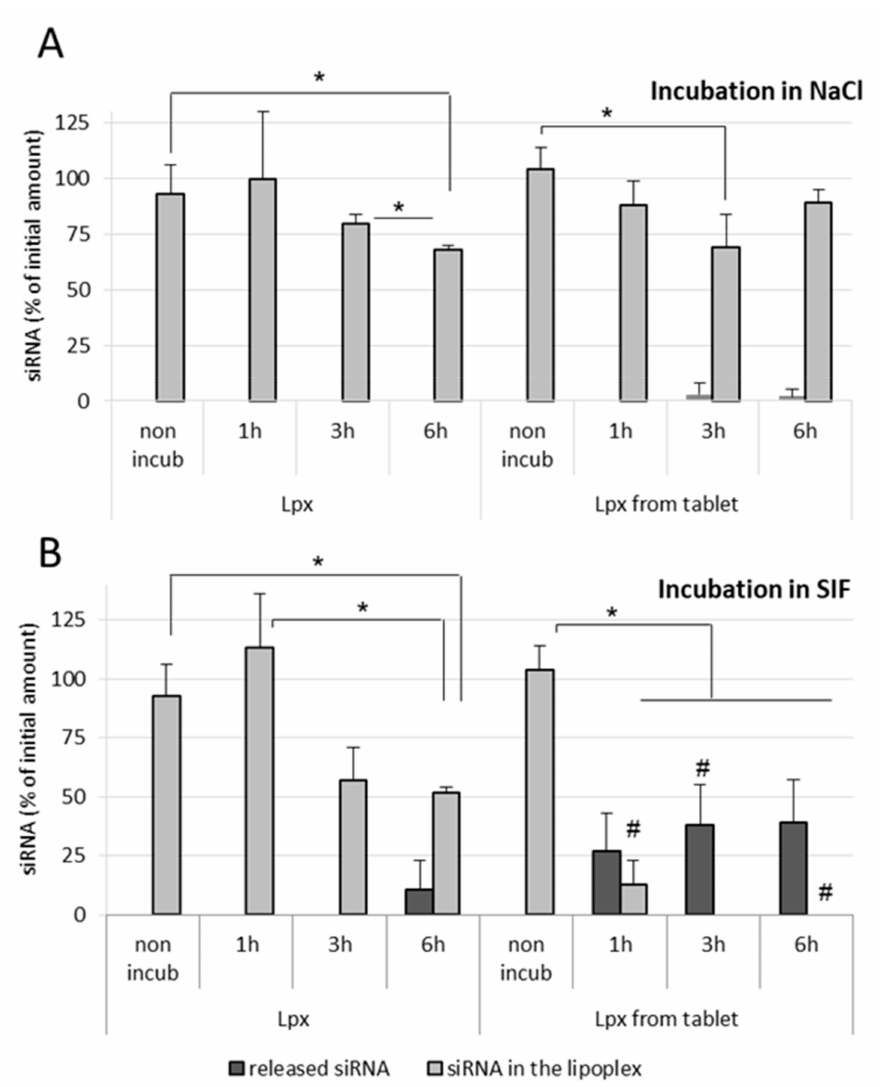
Figure 6. Effect of NaCl (150 mM) ( A ) and simulated intestinal conditions ( B ) on the stability of siRNA lipoplexes. siRNA lipoplexes freshly prepared (Lpx) or resuspended from tablets (Lpx from tablet) were incubated for 1 h, 3 h and 6 h at 37 ◦ C in NaCl ( A ) or SIF ( B ). Nonincubated (non-incub) samples were also studied. The percentage of siRNA released or preserved within lipoplex was quantified by gel electrophoresis as described in Material and Methods. The results were expressed as % initial amount of siRNA used (mean values ± SD, n = 3–5; * statistical significance between different treatments applied to the same type of lipoplex, * p < 0.05; # statistical significance between Lpx and tableted Lpx undergoing the same treatment, # p <